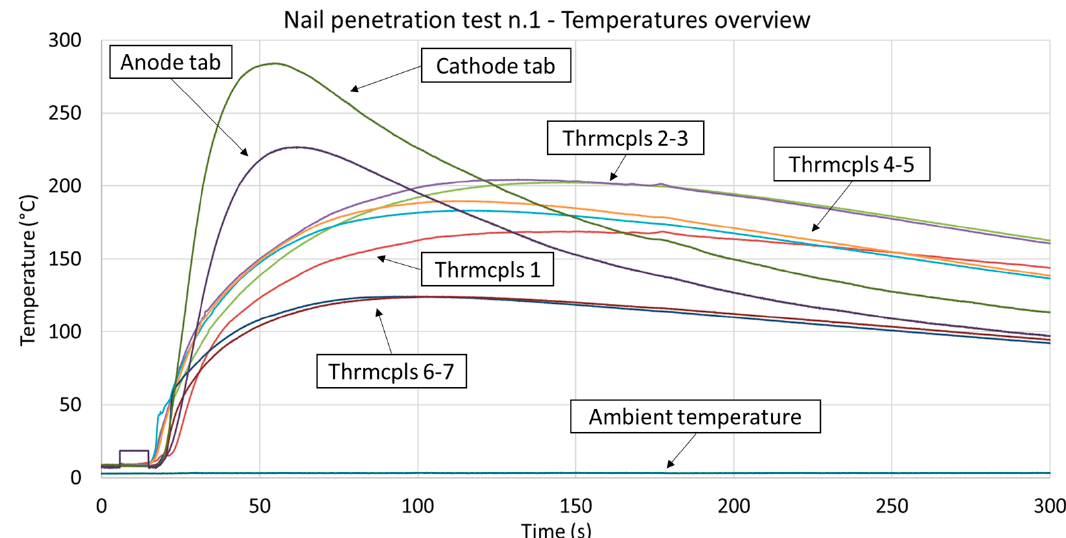
Figure 7. Temperature measurements made in the nail penetration test. The thermocouples num- bers and position are described in Figure 5. The temperatures of the anode and cathode tabs in- creased more rapidly in the initial stage of the test. Thermocouples 6 and 7 registered markedly lower temperatures due to their greater distance from the nail. The ambient temperature was within the range 0–5 °C.